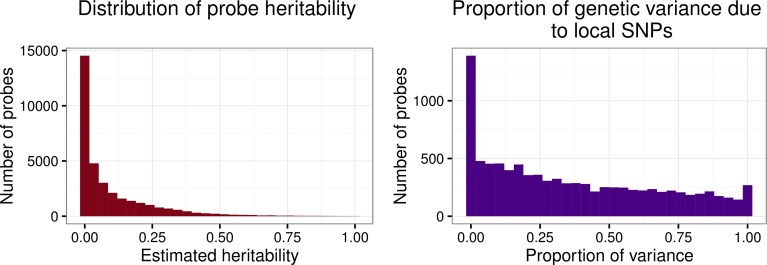
Expression heritability and proportion of genetic variance due to local effects.Distribution of estimated heritability of probe expression obtained using Mendel for all 34,030 probes (left), and distribution of the proportion of total genetic variance attributed to local genetic variation (right) for the 9,458 significantly heritable probes (FDR<0.05) where partitioning using the multiple GRM approach in GCTA was possible.